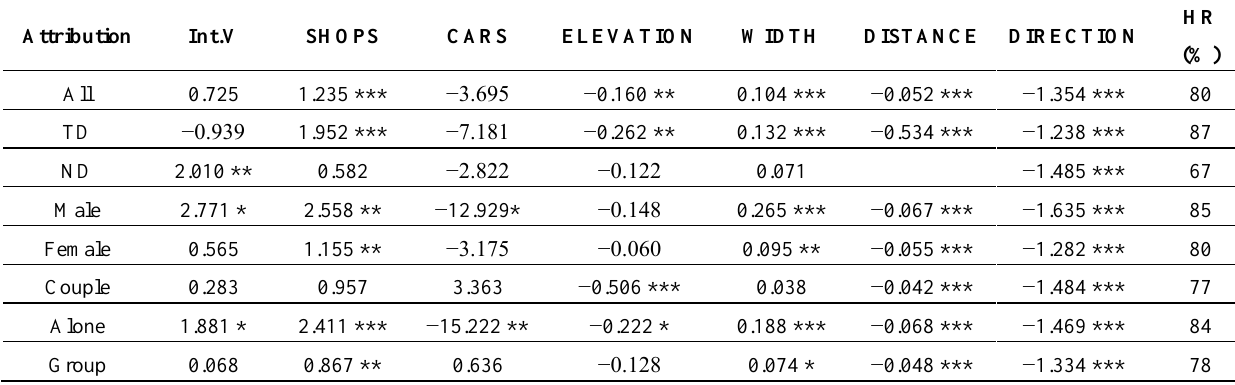
Table 8. Each estimated parameter and hitting ratio